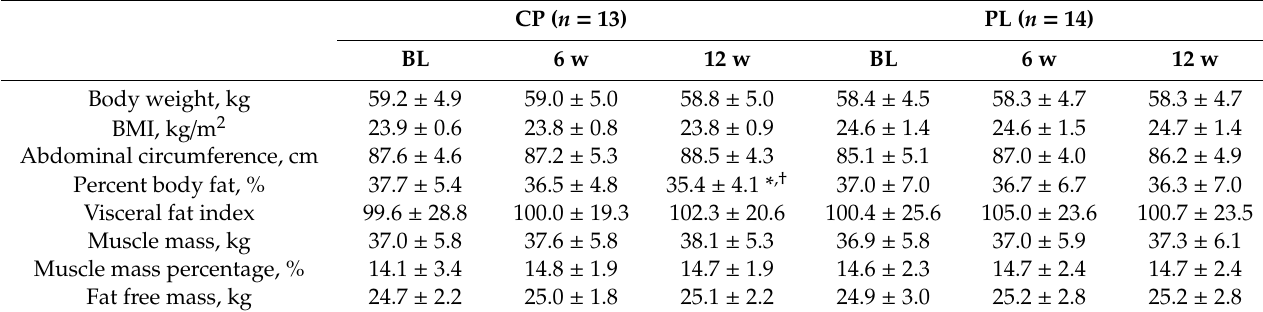
Table 6. Physical attributes in overweight